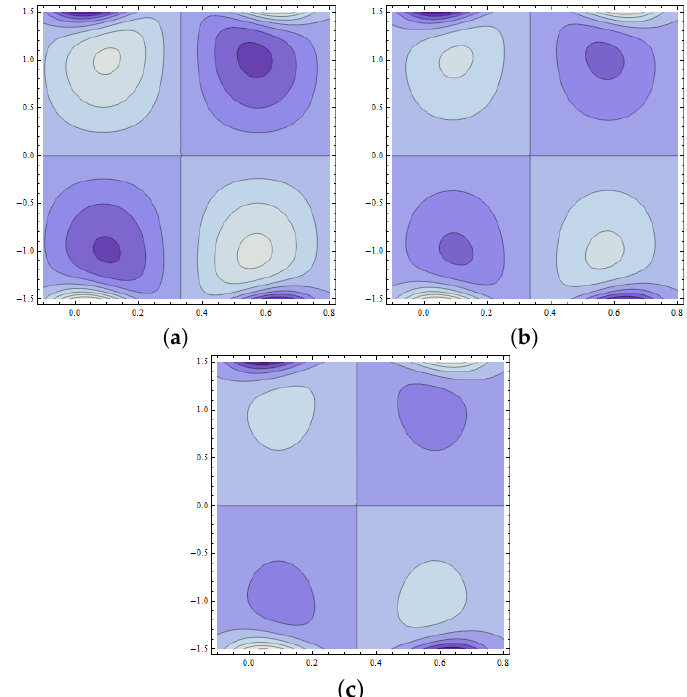
Figure 18. Pattern of streamlines when (cid:101) = 0.1, t = 0.1, m = 0.04, m 1 = 2, E 2 = 0.2, E 3 = 0.3, n = 0.4 and We = 0.4 with ( a ) E 1 = 0.2, ( b ) E 1 = 0.3, ( c ) E 1 = 0.4.